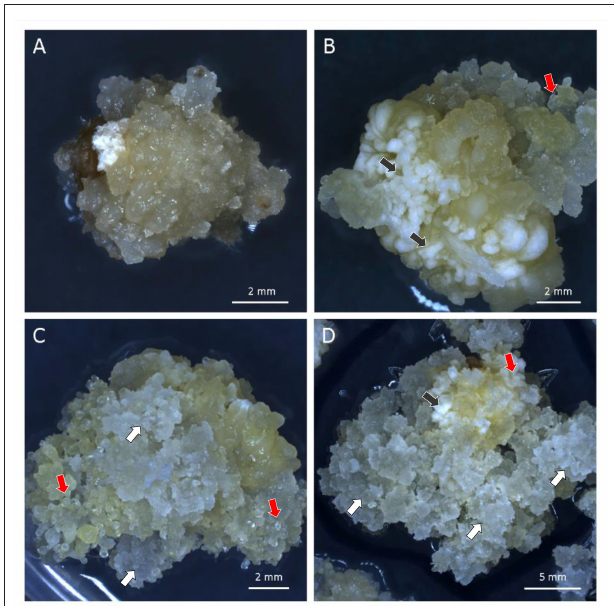
FIGURE 3 | Different types of embryogenic callus. (A) Non-embryogenic callus of FFMM-A; (B) Embryogenic callus of FFMM-ATU1; (C,D) Embryogenic callus of FFMM-AT6R. Black arrows, Type-I compact callus; White arrows, Type-II friable callus; Red arrows, Type-1.5 callus. All three regenerable types were produced from 9 DAP immature embryos and cultured on 605J medium for 26 days.